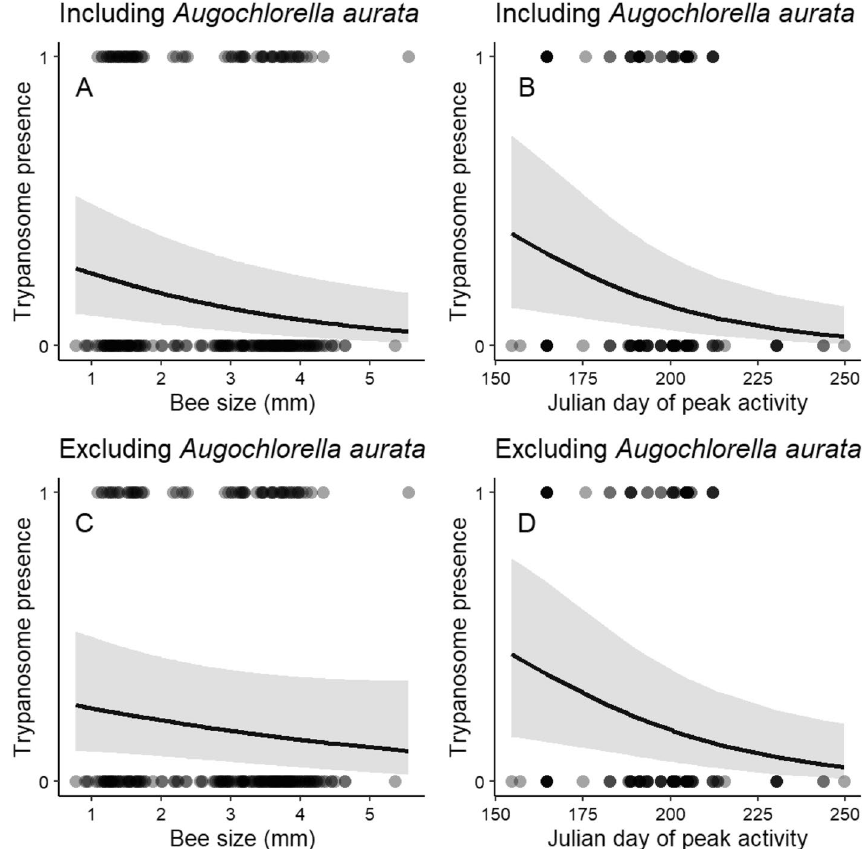
Figure 4. Relationship between bee size and trypanosome prevalence in the overall community ( A ) when A. aurata included and ( B ) when A. aurata excluded. Relationship between peak seasonal activity (in Julian days) and trypanosome prevalence ( C ) when A. aurata included and ( D ) when A. aurata excluded. Shaded confidence interval corresponds to standard error. The regression lines are based on the model output (Table S6). Data are presented as proportions for ease of visualization in Fig.